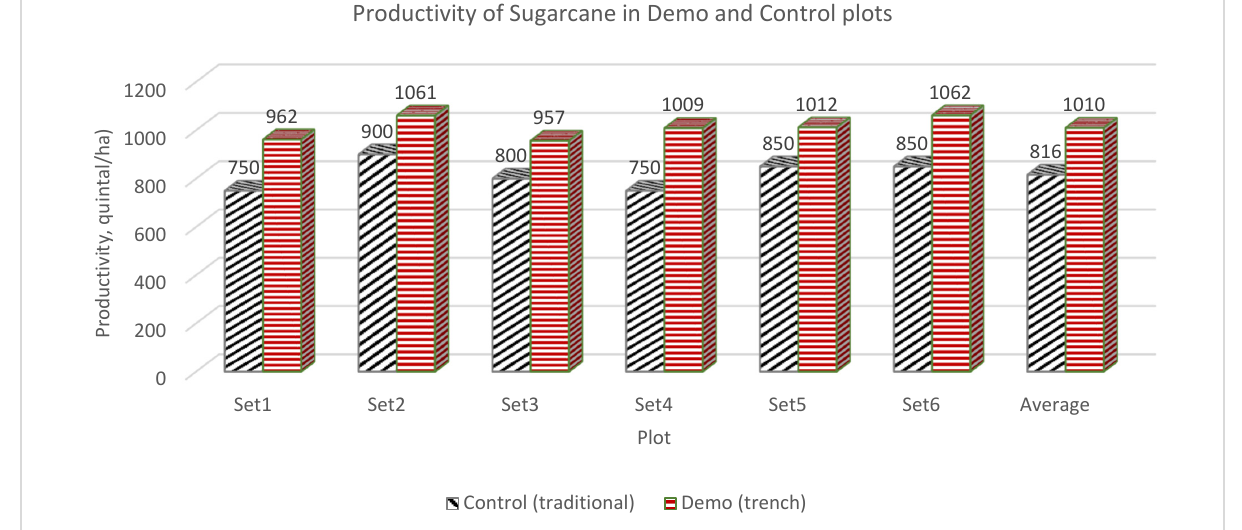
Figure 7. A comparison of productivity of sugarcane (Better Management Practices including trench vs traditional methods).